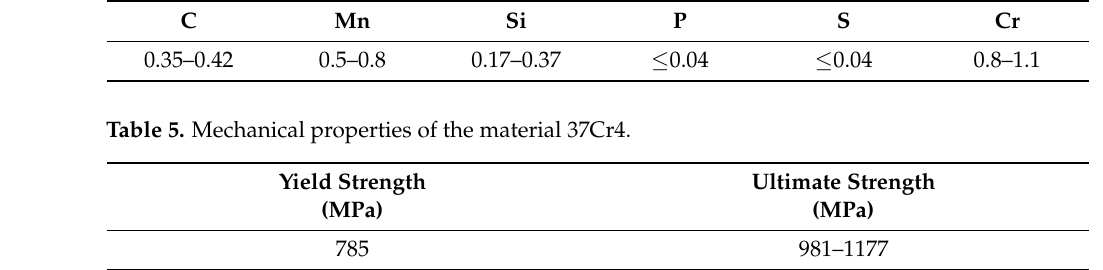
Table 4. Chemical composition of the material 37Cr4 (%). Table 5. Mechanical properties of the material 37Cr4.